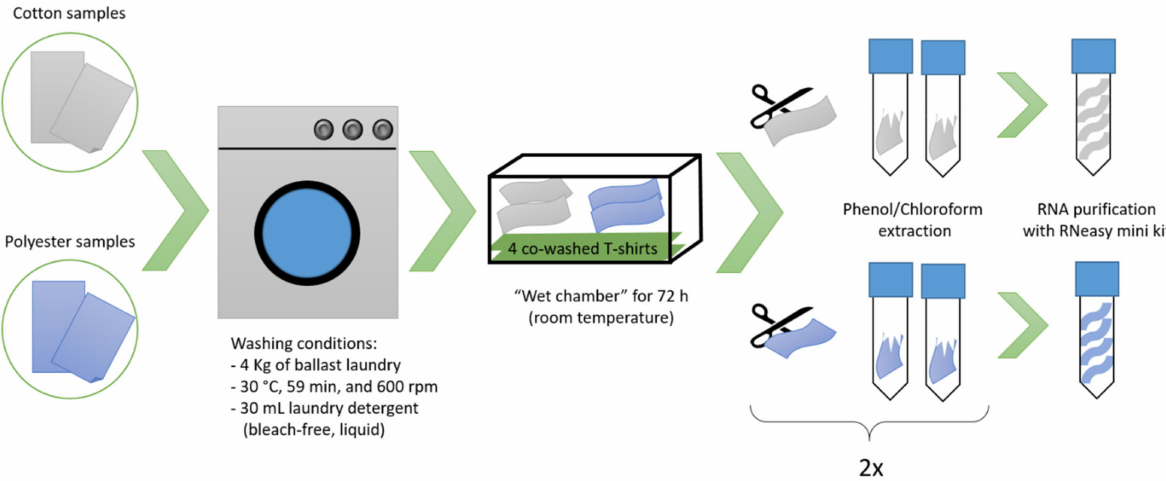
Figure 1. Schematic overview of a single washing experiment. Two sterile cotton (grey) and polyester (blue) textile samples (120 cm 2 each) were washed in a standard household washing machine under mild conditions. Subsequently, the textile samples were incubated in a “wet chamber” for 72 h at room temperature. Each lobe was cut into smaller pieces under sterile conditions and distributed over two reaction tubes. After the phenol/chloroform extraction, the RNA from the two cotton and polyester lobes, respectively, were combined into a single RNA extract using the RNeasy Mini Kit. This experiment was replicated once, finally yielding two independent cotton and polyester RNA extracts each (n =